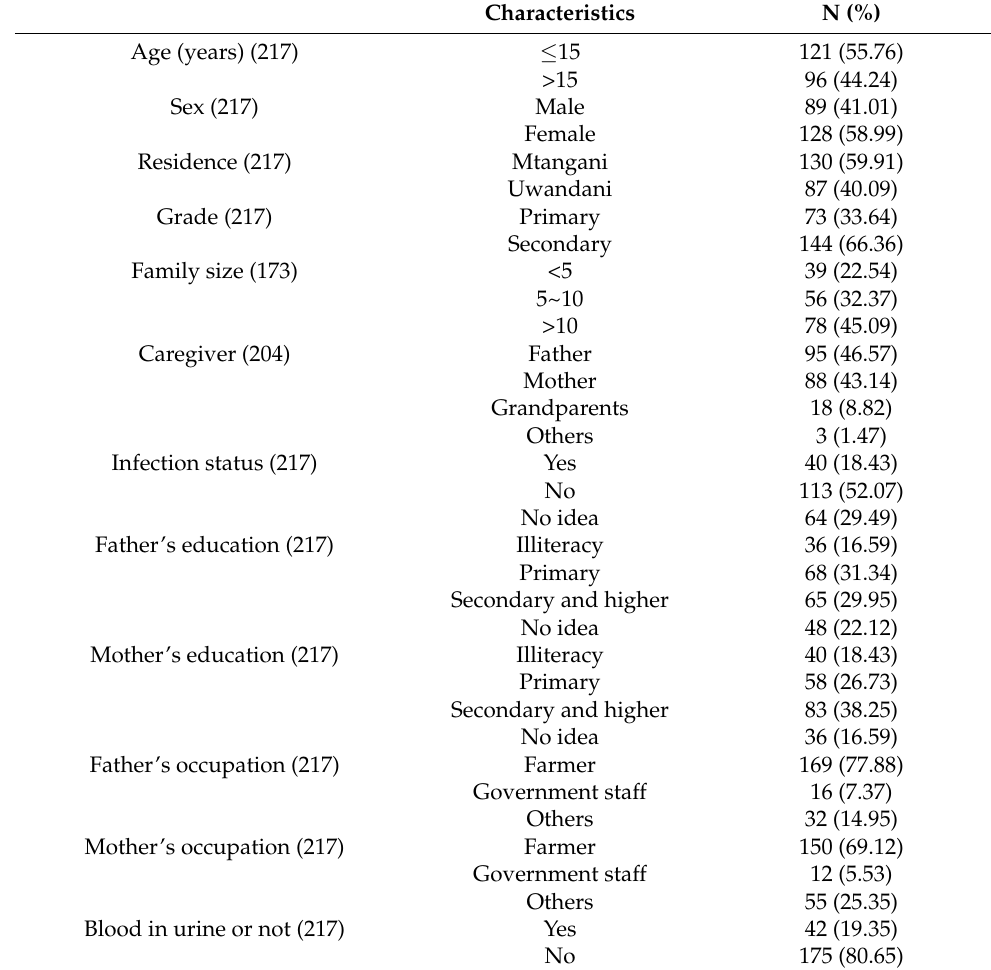
Table 1. Participant